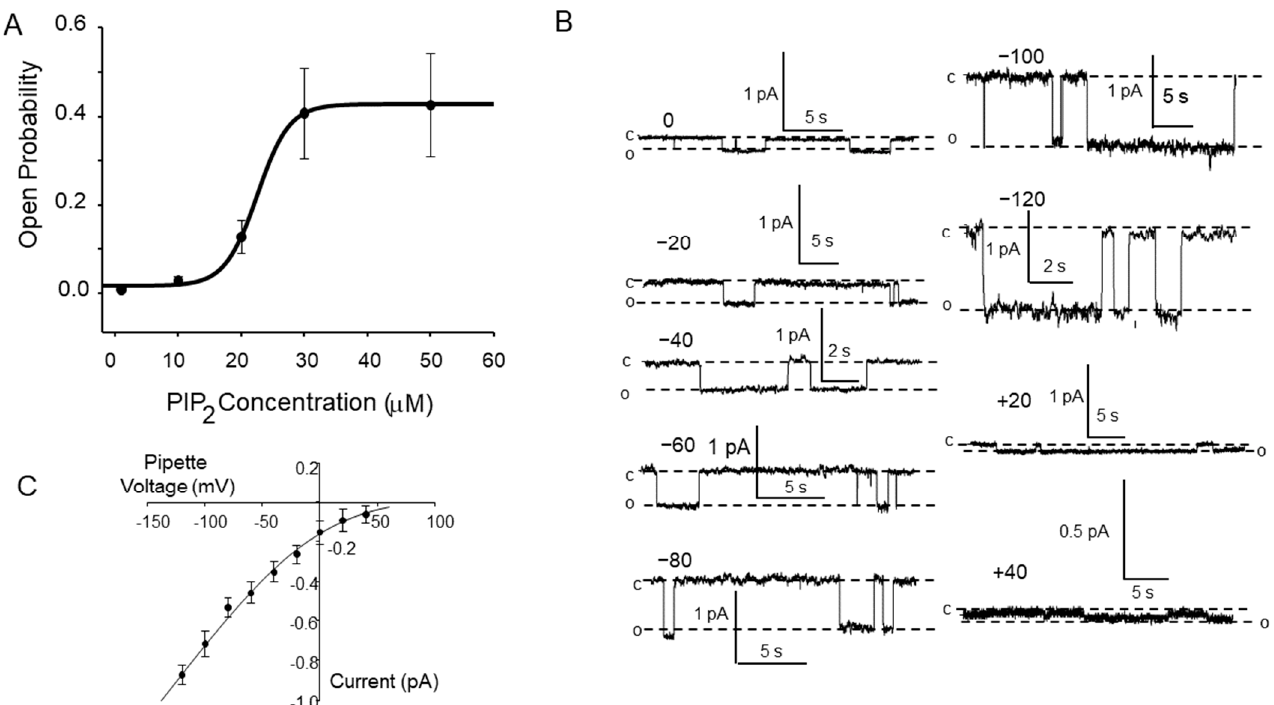
Figure 3. Dose-response relationship for PIP 2 activation of ENaC and current-voltage relationship for ENaC in excised patches from H441 cells. In Panel ( A ), we fit the open probability vs. PIP 2 concentra- tion to the Hill equation (see text). The half-activating concentration of PIP 2 was 22 ± 0.66 µ M with a maximal open probability of 0.411 ± 0.0156. The Hill coefficient is 2.5 ± 0.55 (r 2 = 0.949). In Panel ( B ), we show representative single-channel events at ten different voltages. The vertical scale bars are the same in all records except +40. The horizontal scale bars vary among records. Channel openings (inward current) are downward. Open and closed levels are indicated with dashed lines labeled “o” and “c,” respectively. Panel ( C ) shows the single-channel current-voltage relationship of 4l channels from excised patches. We fit the single channel current to the Goldman Current Equation [34] that gave a unit conductance of 6.6 ± 1.4 pS between − 120 and − 40 mV. It also predicted the observed inward rectification at positive potentials and a reversal potential of 83 ± 3.1 mV. These numbers are consistent with ENaC exposed to high 140 mM LiCl in the pipette and low 3 mM Na + on the cytosolic surface.